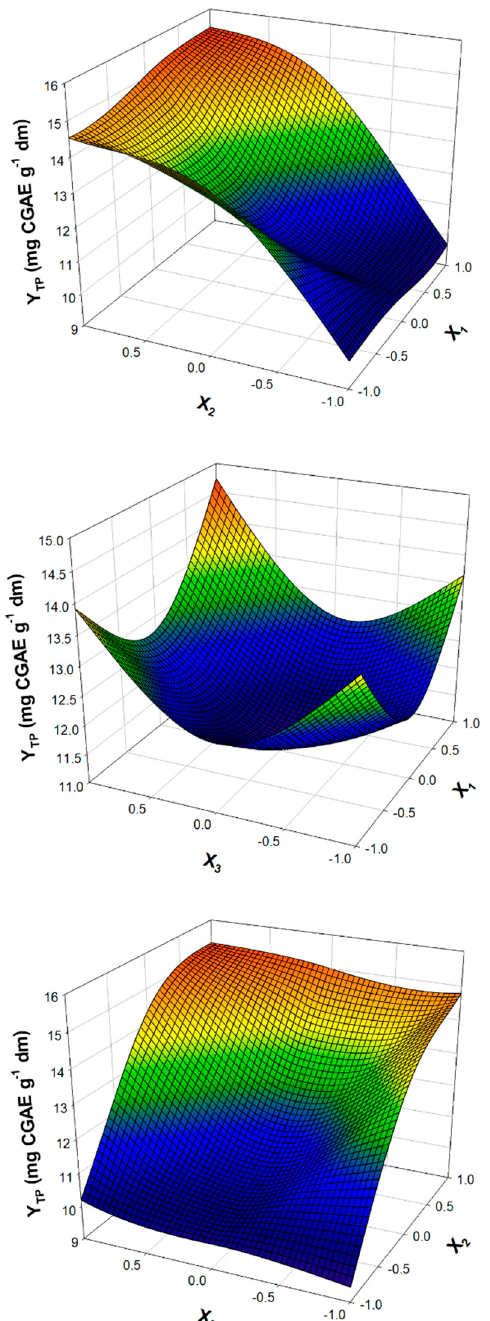
Figure 3. Three-dimensional diagrams portraying the effect of process variables on the response.